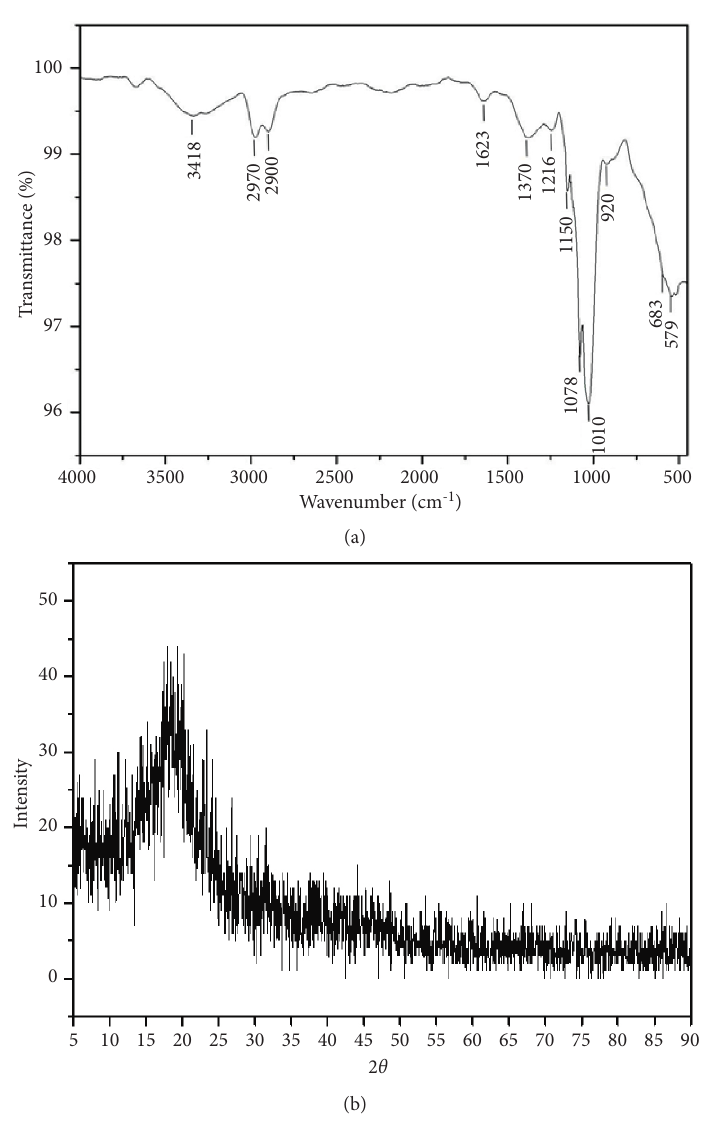
Figure 5: The structural characterization of TSP: (a) FT-IR spectroscopy of TSP, indicating different functional groups, and (b) XRD analysis of